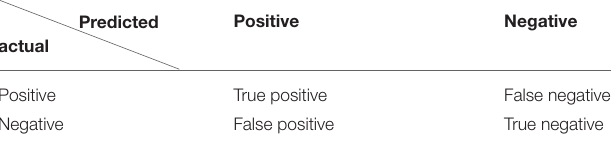
TABLE 2 | Confusion